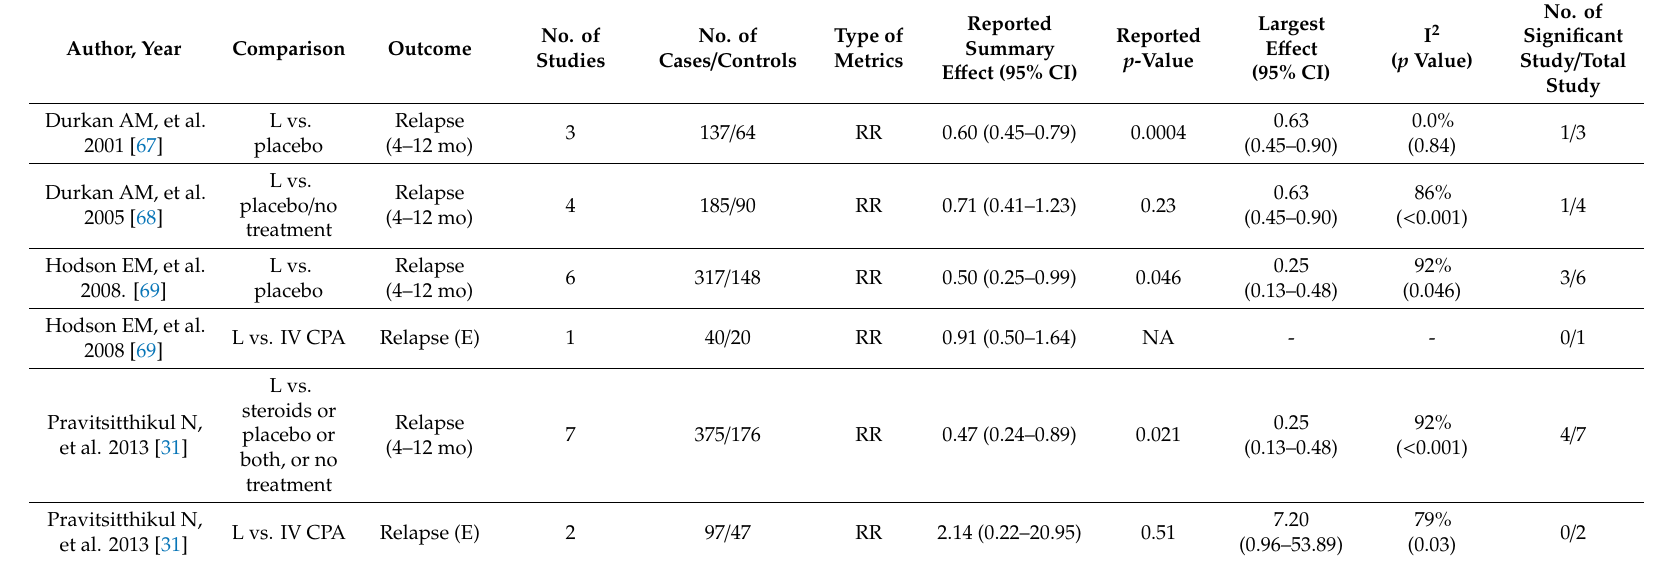
Table 3. Summary of meta-analysis of RCTs on levamisole treatment in nephrotic